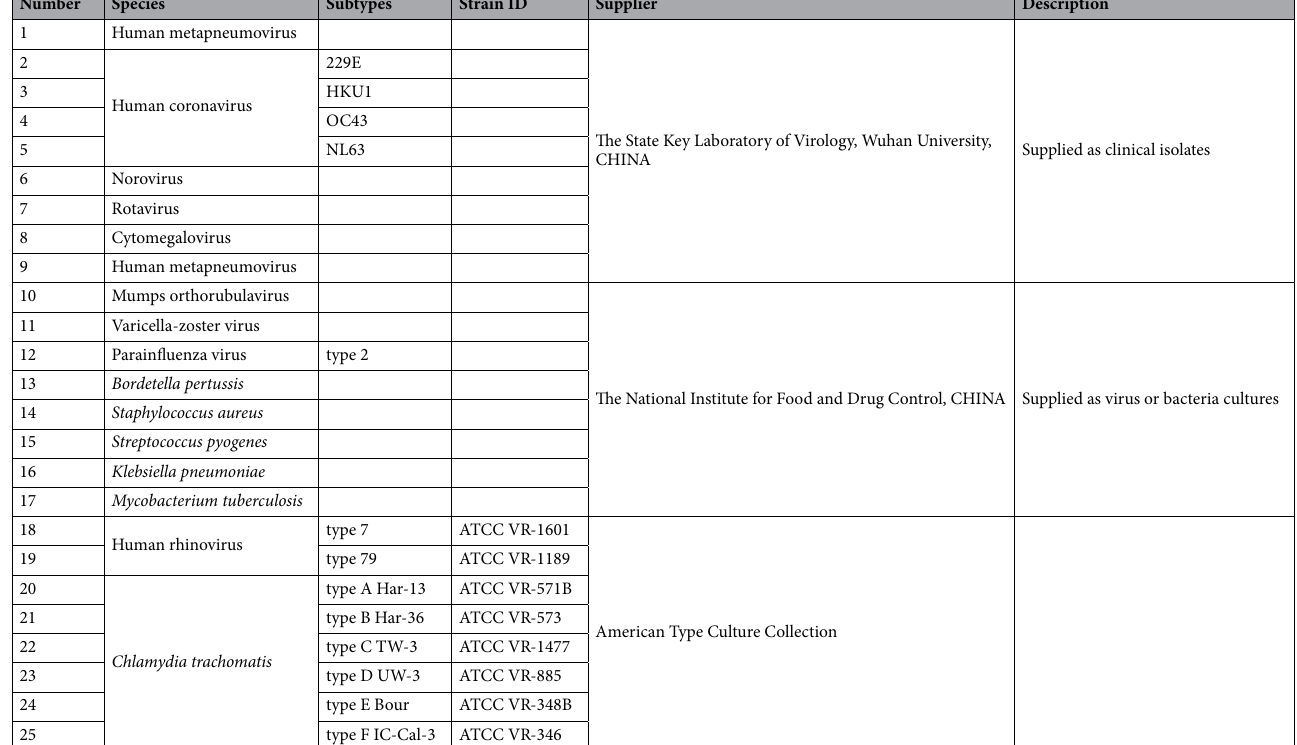
Table 7. Pathogenic microorganisms, including culture strains and laboratory isolates, used as the control pathogens in evaluation of the three-tube multiplex real-time